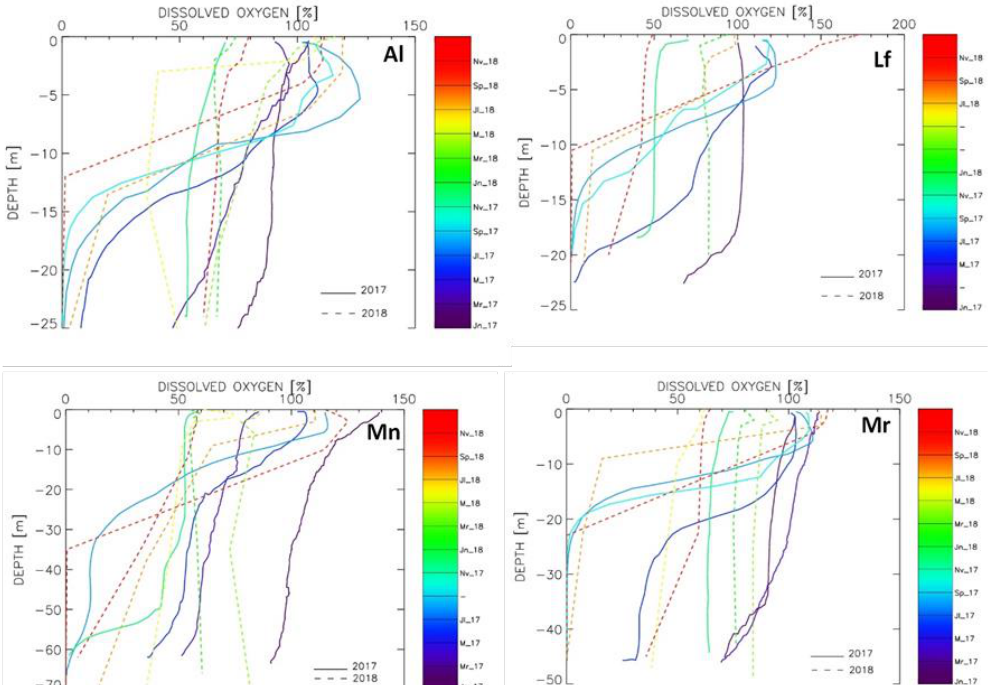
Figure 6. Dissolved oxygen profiles, at the four sampling locations at Alqueva reservoir, in the months of January (Jn), March (Mr), May (M); July (Jl); September (Sp) and November (Nv), during 2017 (full lines) and 2018 (dashed lines). Al: Á lamos; Mn: Montante; Mr: Mourão; Lf: Lucefécit.